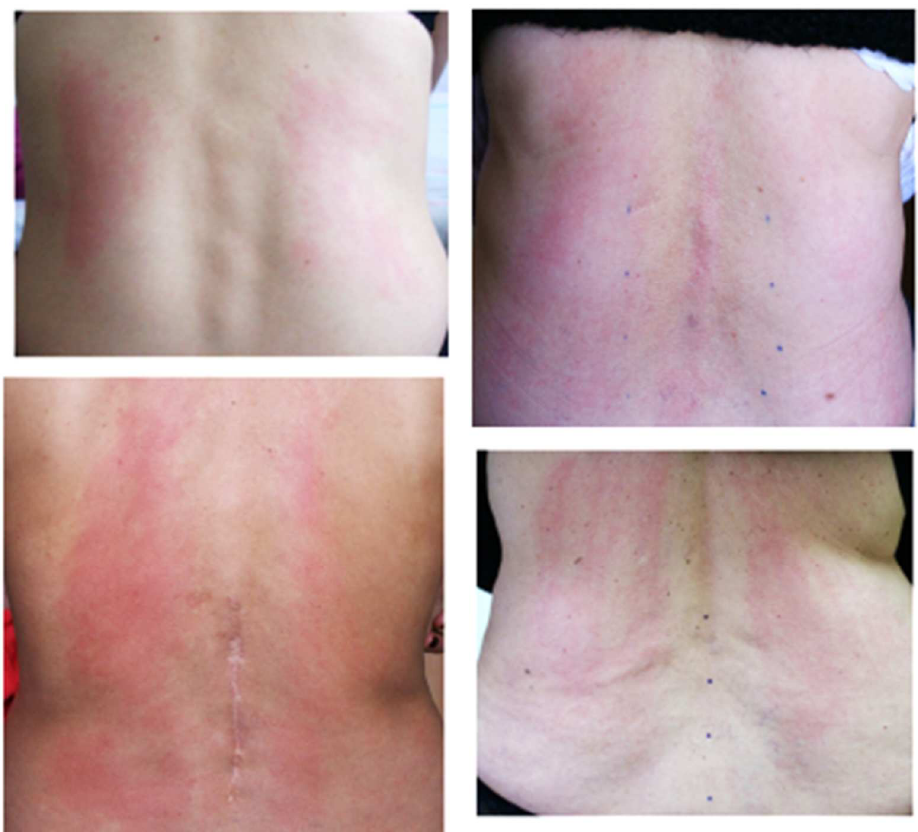
Figure 2. Examples of asymmetry.